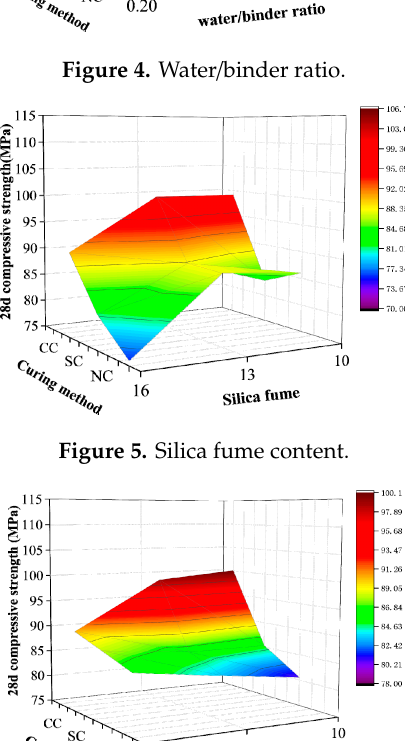
Figure 6. Fly ash content.